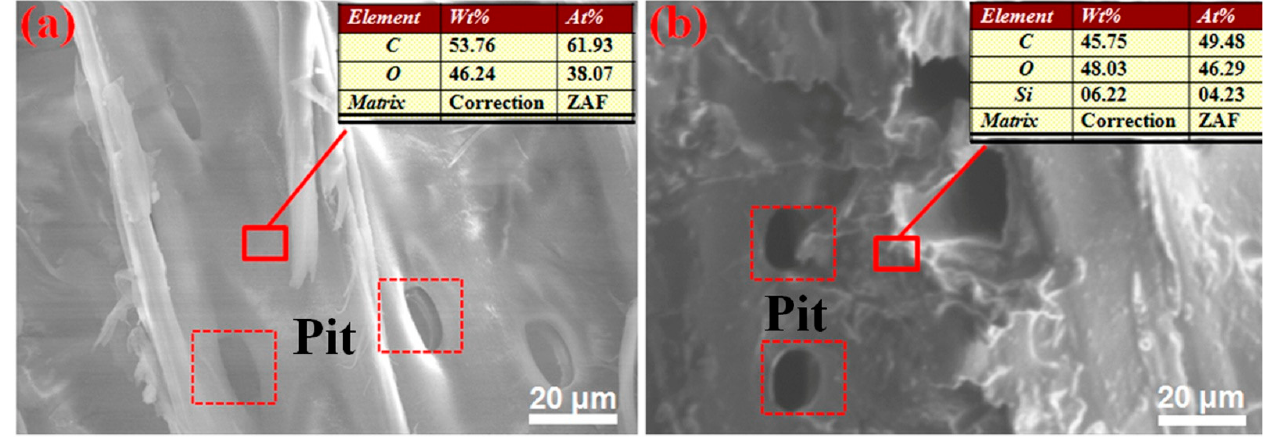
Figure 4. SEM images and EDS analysis of wood before ( a ) and after ( b ) 25% D4H modification.